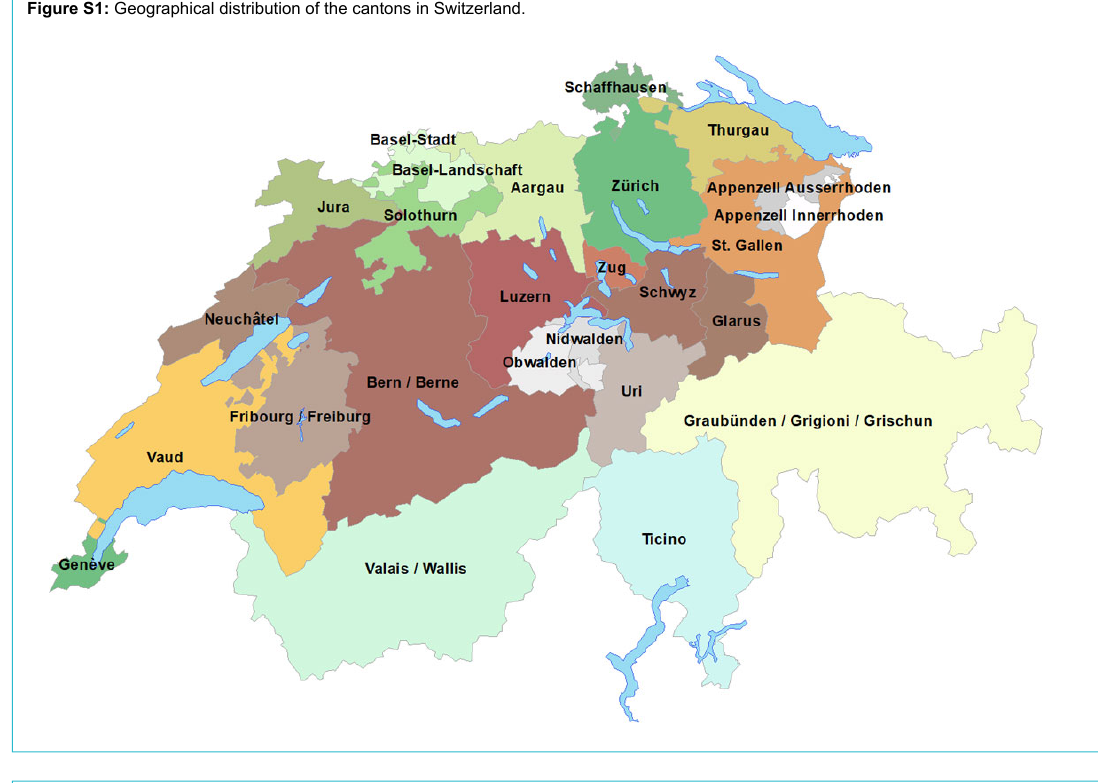
Figure S1: Geographical distribution of the cantons in Switzerland.